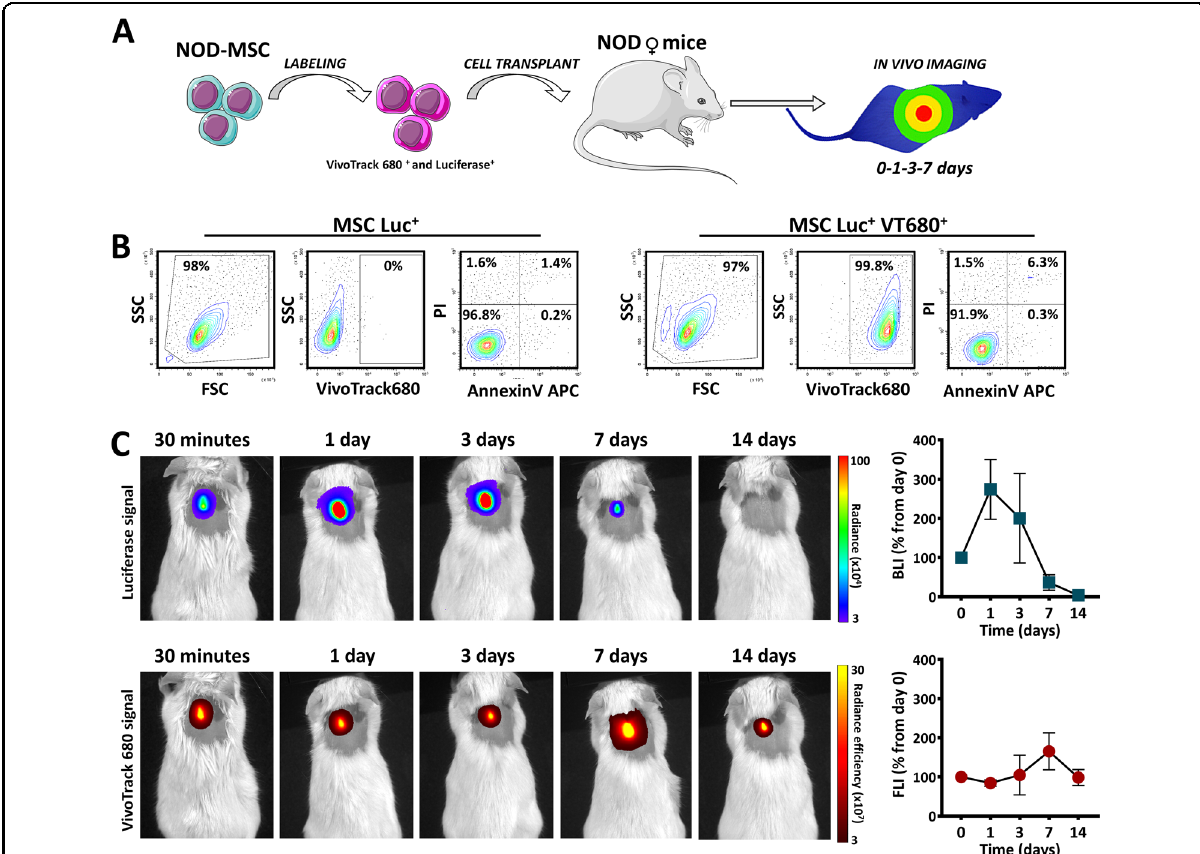
Fig. 1 Survival of MSC after in vitro double labelling with Luciferase and VT680 followed by subcutaneous transplantation into NOD female mice. A Schematic representation of the experimental work fl ow. This fi gure was made with Servier Medical Art templates, which is licensed under a Creative Commons Attribution 3.0 Unported License: https://smart.servier.com. B Preservation of cell viability after in vitro labelling of Luc + MSC with VT680. Note than VT680 labelling produced minimal changes in cell viability of Luc + MSC and that the majority of cells were not affected by the second labelling. C The time-course images of BLI and FLI signals produced by double-labelled MSC after subcutaneous transplantation in a NOD mouse. The quantitative data from fi ve mice is given on the right side. Data are plotted as mean ± SEM. Note the high increase in the BLI signal at day 1. However, due to the large variability in the animal responses, the increase is not statistically signi fi cant (one-way ANOVA followed by Tukey ’ s